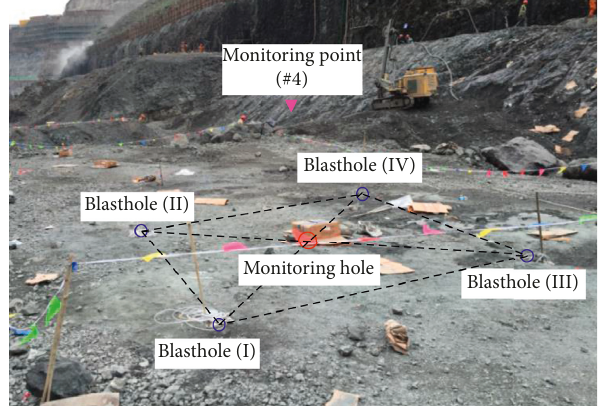
Figure 16: On-site layout of blastholes in the single-hole blasting experiment. Table 3: Drill and blast parameters in the single-hole blasting experiment.